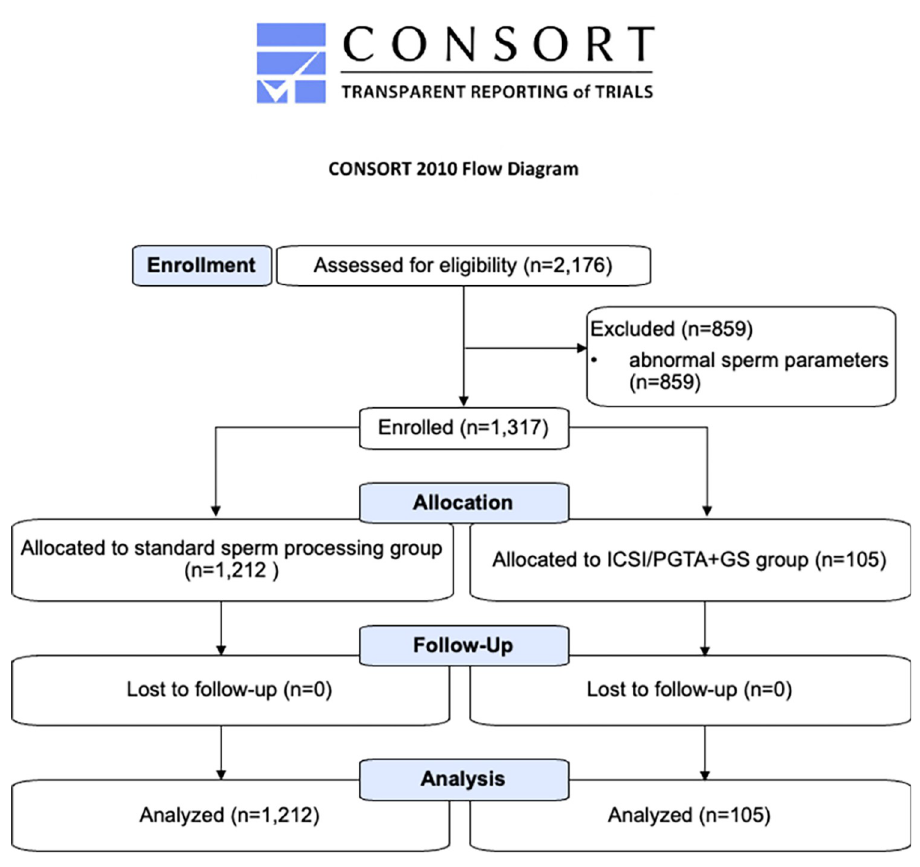
Fig 1. CONSORT flow